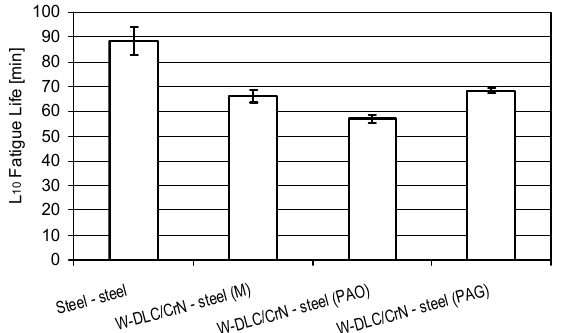
Figure 9. L 10 fatigue lives obtained in the pitting tests.